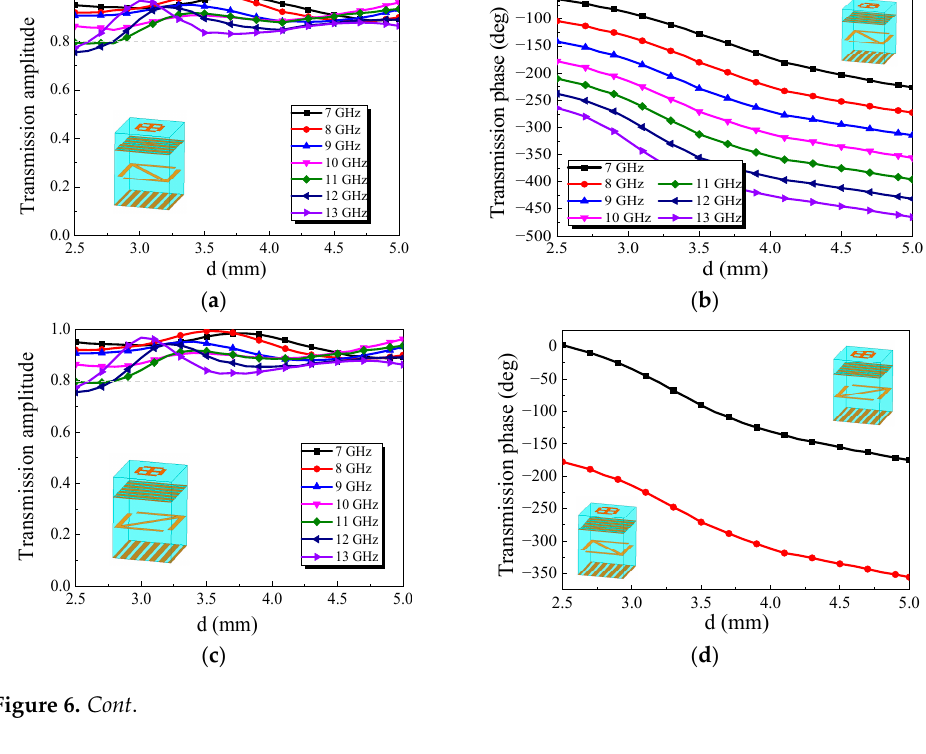
( f ) Figure 6. Simulation results of transmission performance: ( a ) transmission amplitude when l 3 = 2 mm; ( b ) transmission phase when l 3 = 2 mm; ( c ) transmission amplitude of the arrow rotated 90°; ( d ) phase comparison before and after arrow rotation at 10GHz; ( e ) transmission amplitude when l 3 = 3.9 mm; ( f ) transmission phase when l 3 = 3.9 mm. As shown in Figure 7, it is the surface current distribution of the element when y - polarized EM wave is incident along the direction of − z . It can be seen from the figure that the induced current is only distributed in the first two layers of the element. It is indicated that the incident EM wave cannot through the upper metal grid to propagate. Therefore, by changing the length of l 3 , the reflected wave property of the element can be regulated. After optimizing the l 3 , the design of low RCS metasurface can be realized when the re- flected phase meets the condition of phase cancellation.